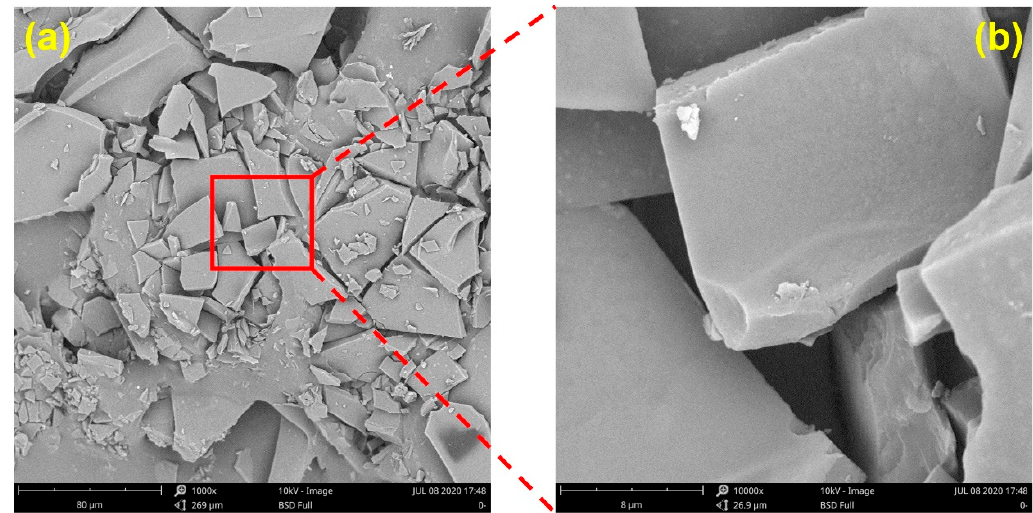
Figure 3. Morphology analysis of SGP-1-1 by SEM. ( a ) 1000-fold; ( b ) 10,000-fold.